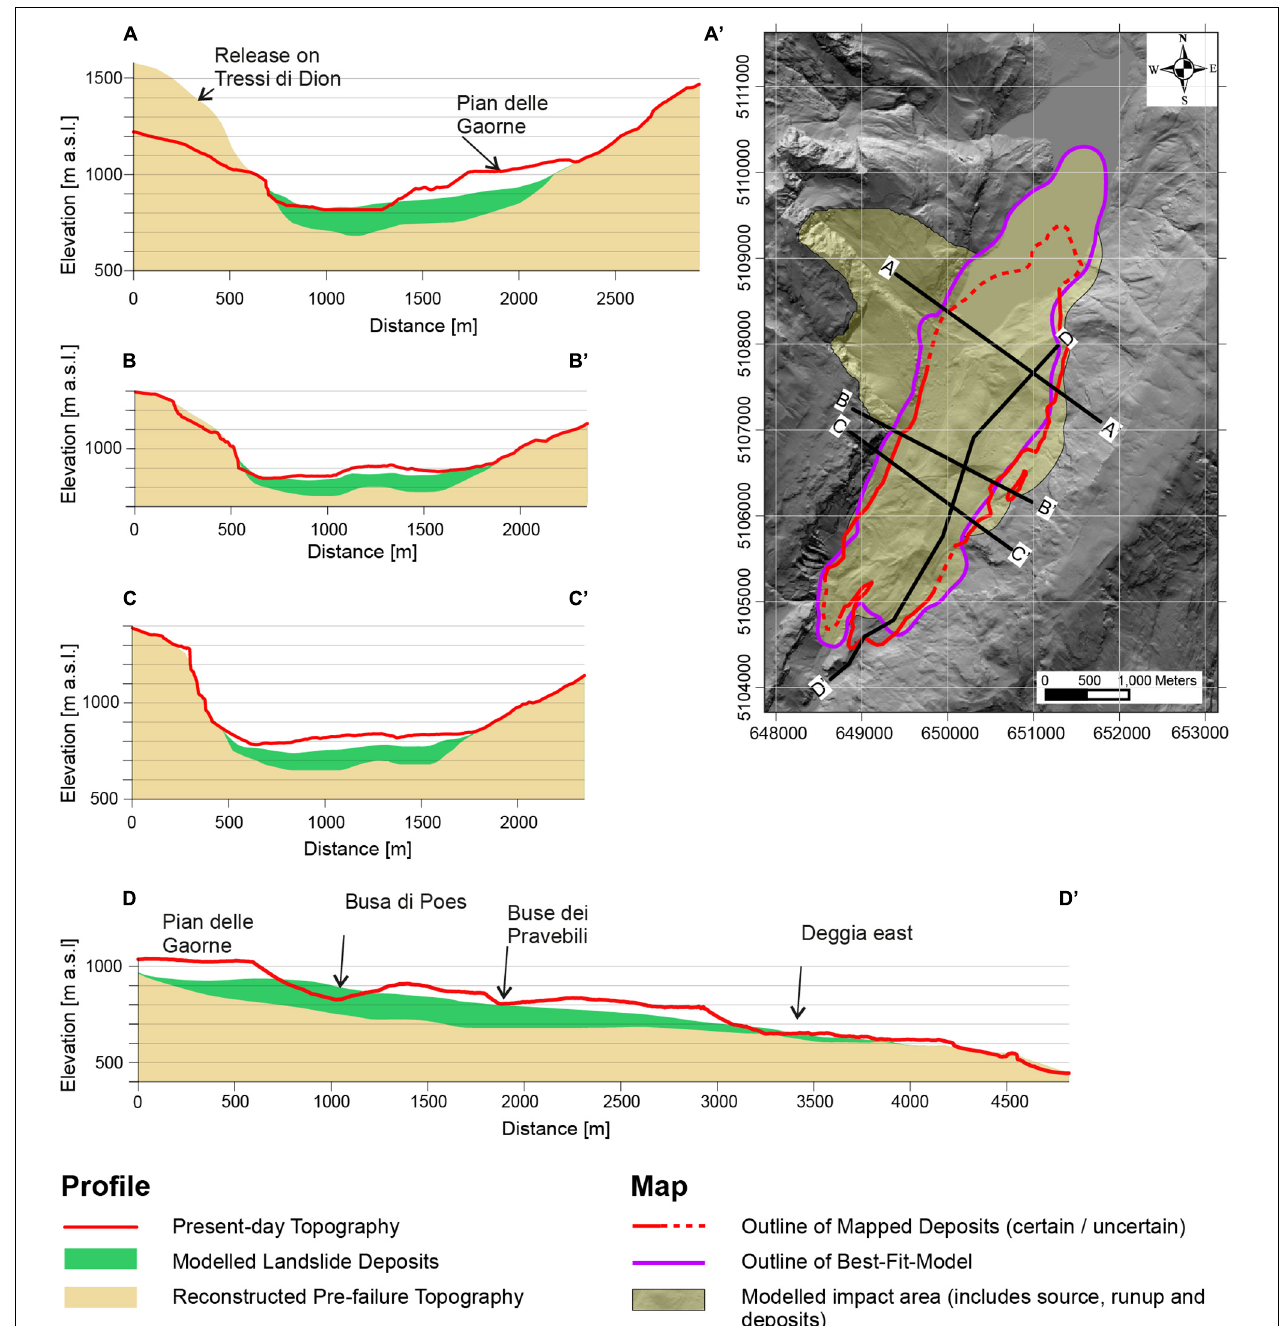
FIGURE 9 | Runout extent and thickness of modeled deposits. Best-fit model run. The modeled run-up on the eastern side could reproduce the mapped deposits and seems hence realistic. The southern margin is also quite well matched, except for the farther end of Deggia East. In the North the runout is too long into the lake. The thickness of the deposits does not match the estimated thickness of the pre-failure topography. Especially the thick deposit at Pian delle Gaorne cannot be reproduced.